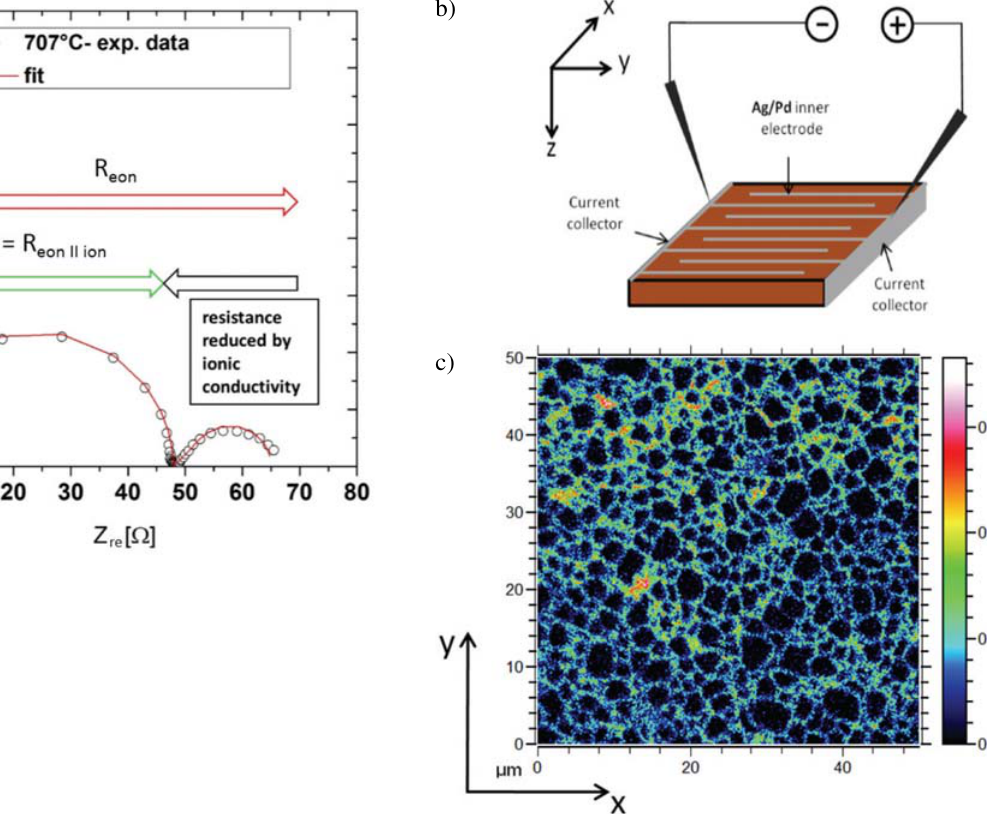
Fig. 8. (a) Impedance spectrum of a PZT multilayer stack piece with interdigitating Ag/Pd electrodes, measured at 707 °C and corrected for wiring inductance. A fit to the simplified circuit in Fig. 6b is also shown. The arrows indicate the meaning of the arcs (diameters) in terms of resistances. (b) Sketch of the sample geometry. (c) 18 O distribution image of a PZT polycrystal after exposure to 18 O SIMS. High 18 O concentrations at grain boundaries clearly indicate that ion transport is mainly along grain